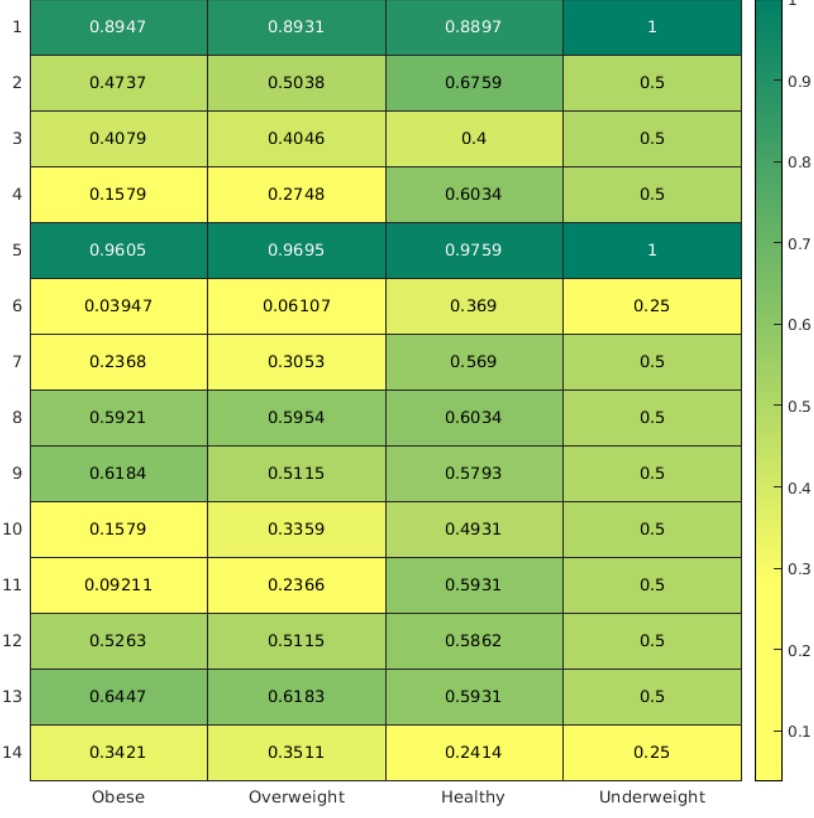
Figure 3. Correlation matrix showing the association between answers to the questions and nutri- tional status.